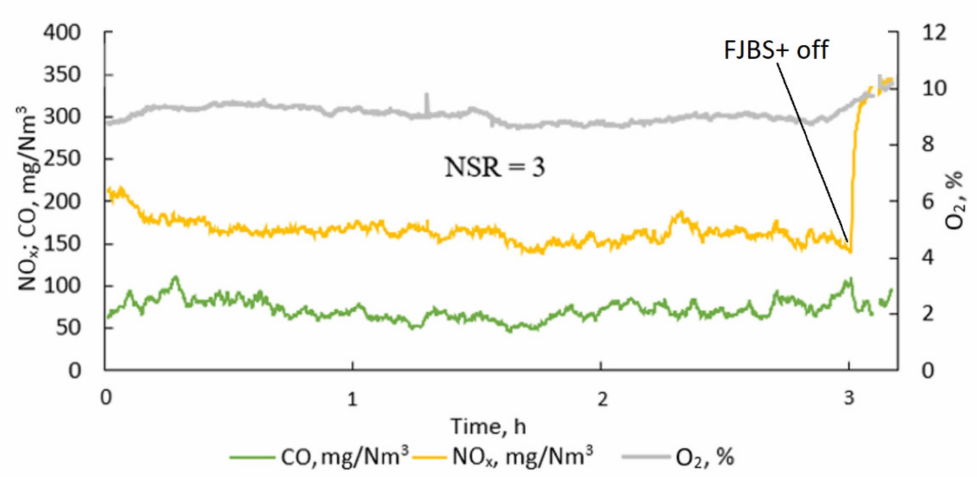
Figure 9. Stack emissions during the hybrid SNCR + SCR system operation at high boiler load of 28 MW th .